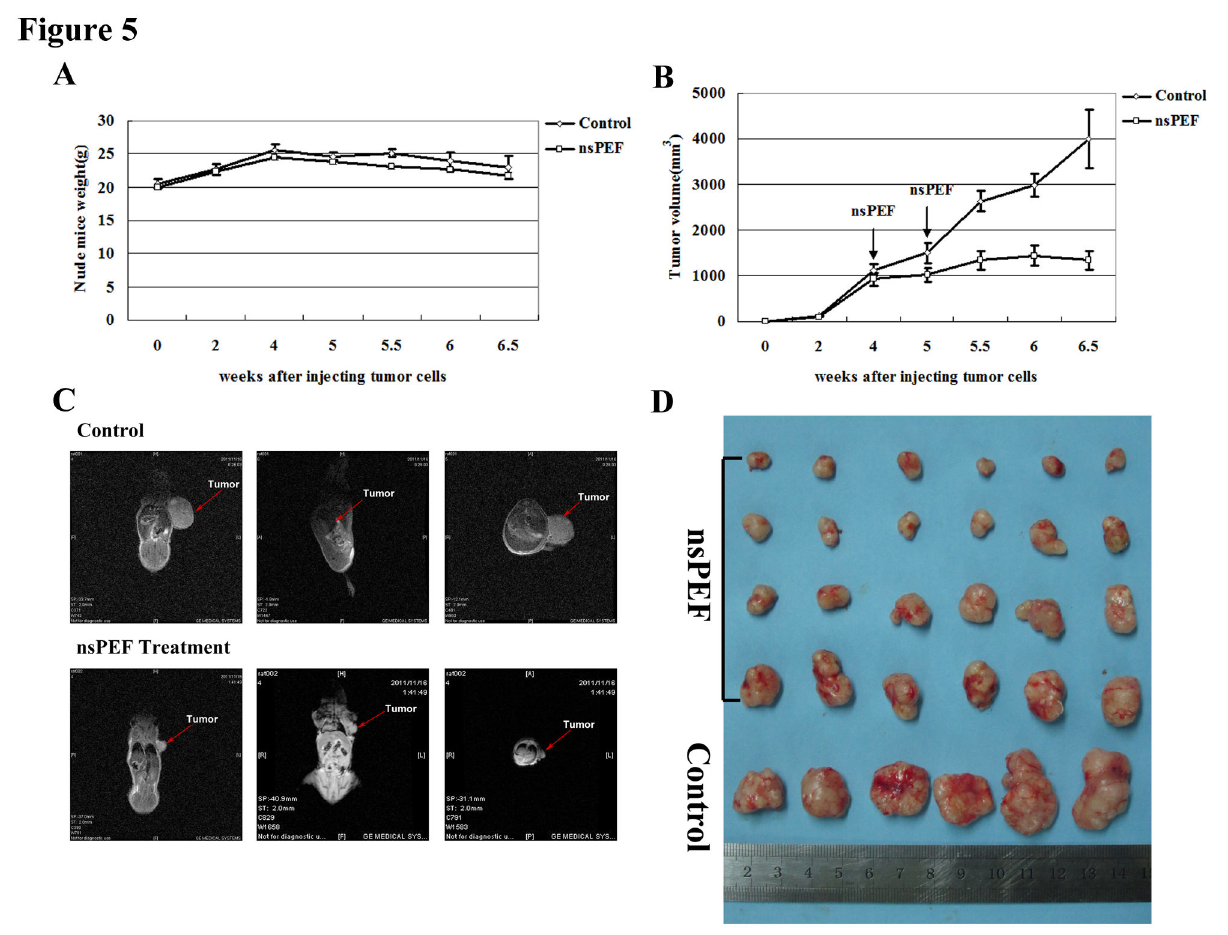
Figure 5. NsPEF functions safely and effectively as an anti-tumor therapy in vivo . (A) Weights of tumor-bearing mice with or without nsPEF at different time after injecting tumor cells were recorded. (B) Growth curve of tumor with or without nsPEF at different time after injecting tumor cells was shown. (C) Visual comparison of tumor with or without nsPEF through in vivo imaging of MRI for tumor-bearing mice was performed. (D) Objective comparison of most tumors in most tumor-bearing mice was performed. doi: